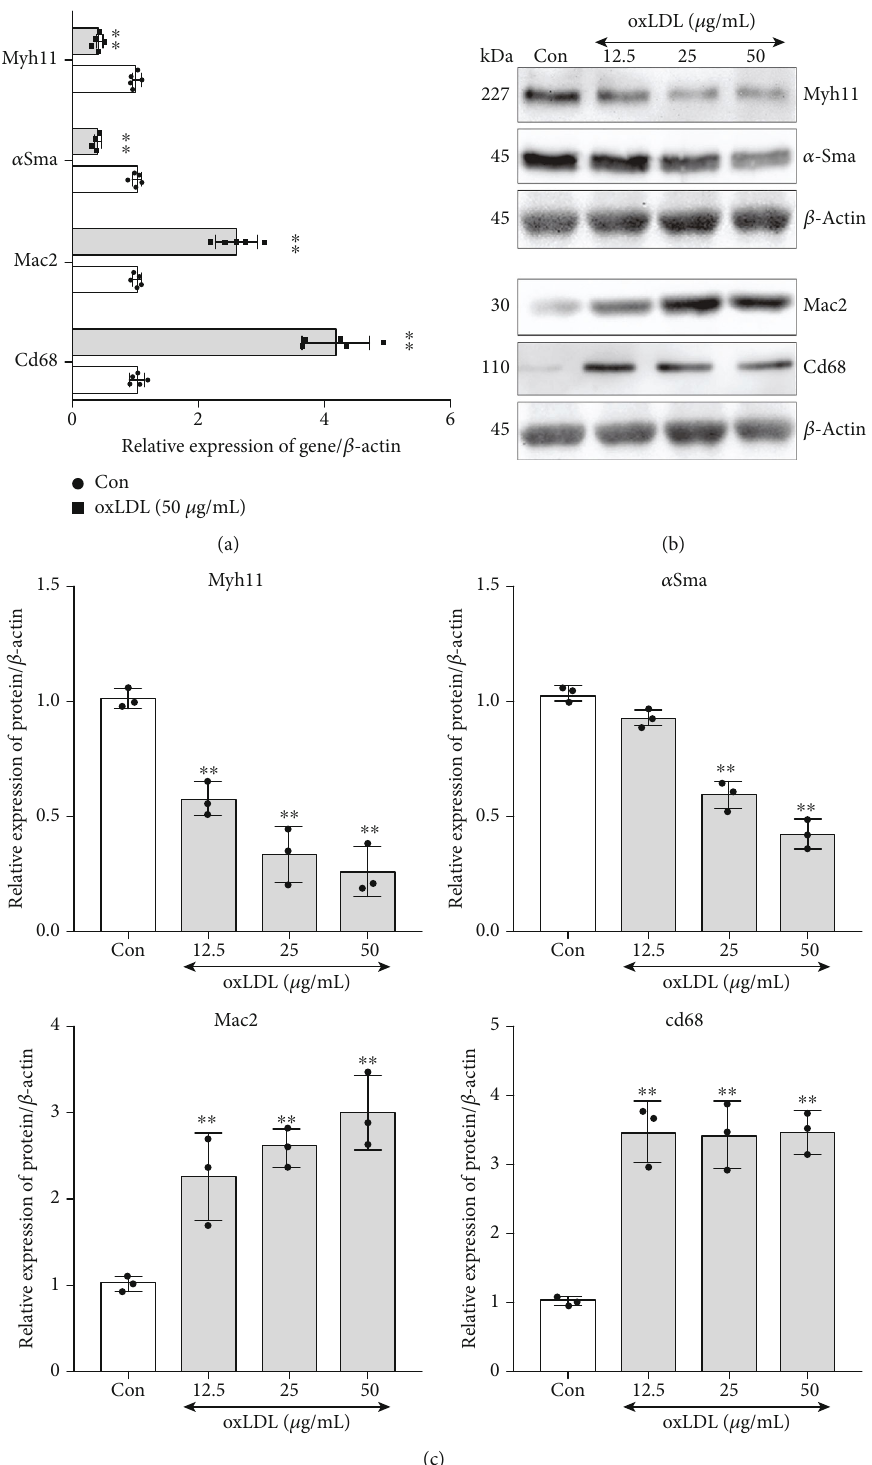
Figure 2: oxLDL promoted foam cell-like phenotype in VSMCs. After oxLDL stimulation, the mRNA or protein expression of genes (Myh11 and α Sma as VSMC contractile phenotype marker, Mac2, and Cd68 as foam cell marker) was detected by real-time PCR or western blot in VSMCs. The untreated group served as control (Con), and β -actin served as an internal reference gene to normalize protein expression. All of the real-time PCR results were calculated with 2 - ΔΔ CT method; the western blot results were calculated using grayscale value. (a) mRNA levels of Myh11 , α Sma , Mac2 , and Cd68 were measured by real-time PCR. ( n = 5 per group, results were expressed as mean ± SD ; (c) ∗ P < 0 : 01 , as compared with the Con group). (b, c) Protein expressions of Myh11, α Sma, Mac2, and Cd68 were measured by western blot ( n = 3 per group, results were expressed as mean ± SD ; ∗∗ P < 0 : 01 as compared with the Con